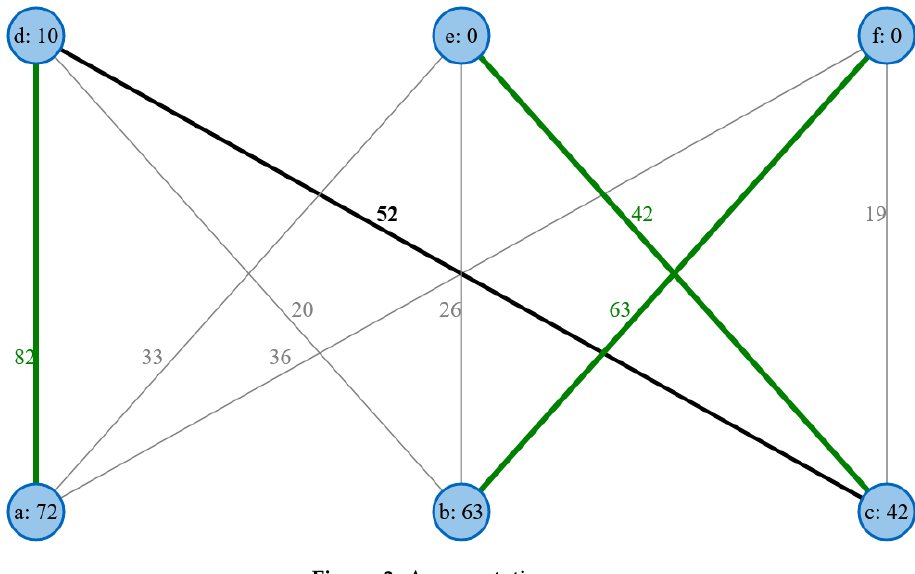
Figure 3. Augmentation way.